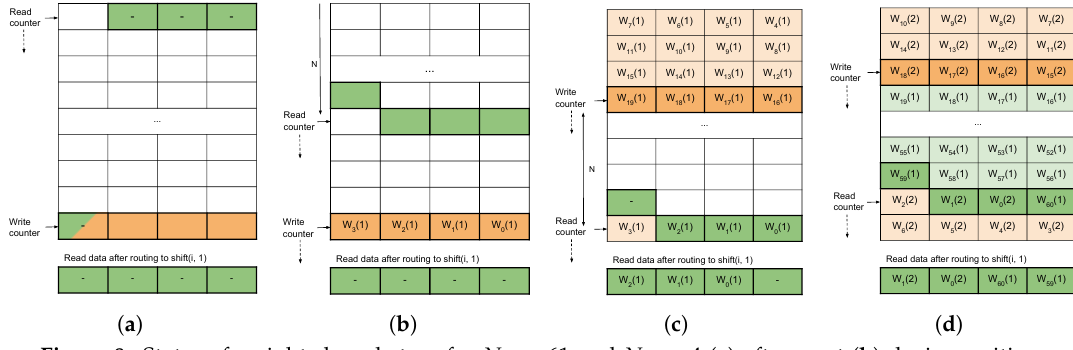
Figure 8. States of weight shared store for N z = 61 and N p = 4 ( a ) after reset ( b ) during writing operation of the first weight samples for pixel 1 ( c ) during reading operation of the first stored weight samples for pixel 1 ( d ) after 15 cycles from the first reading operation for pixel 1.